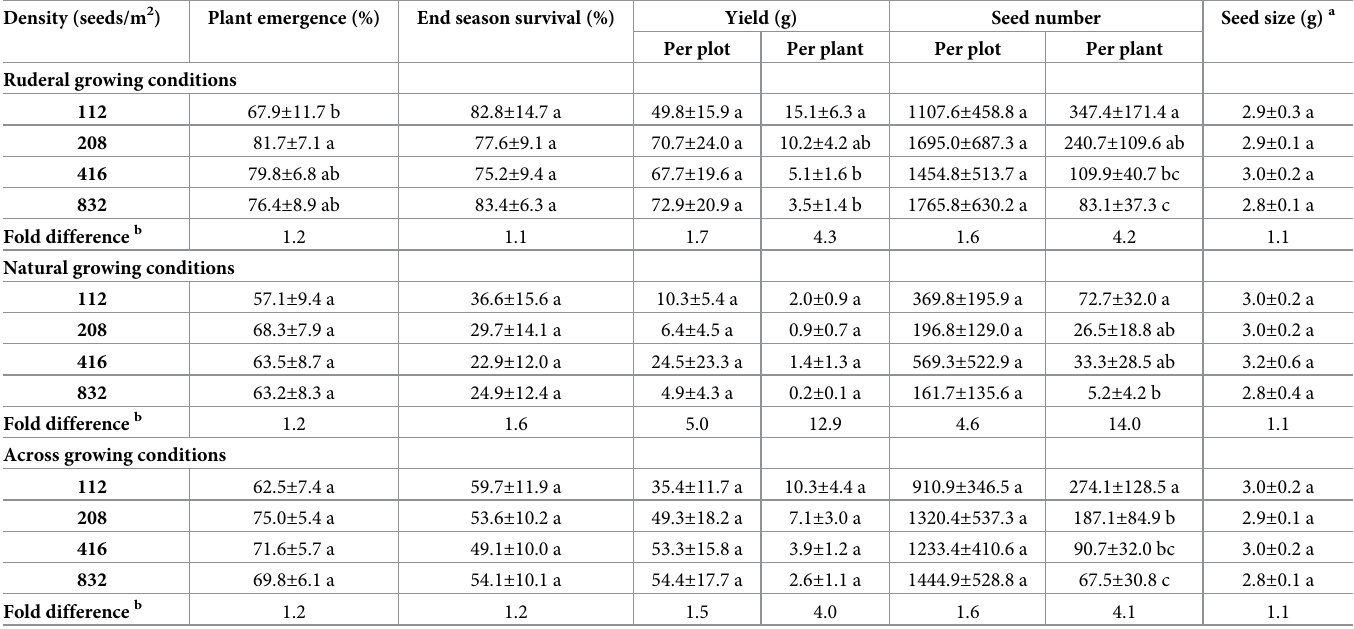
For each growing condition and characteristic, significant differences at 0.05 level among plant densities are designated by different letters. a Seed size was expressed as 100 seed weight. b Fold difference between minimum and maximum values observed for different planting